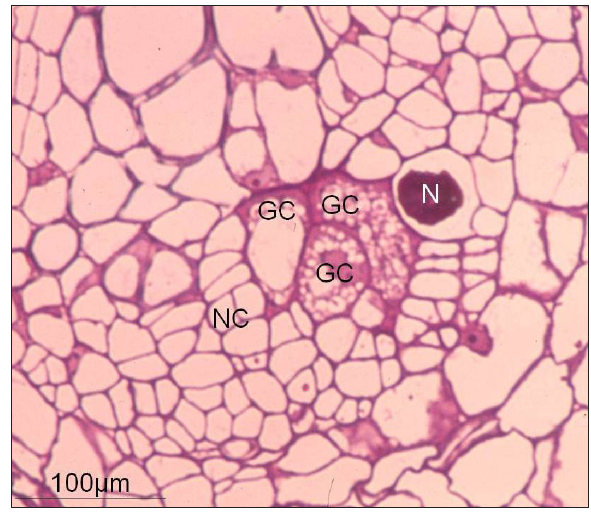
A transmission electron micrograph of a transverse section through an undifferentiated provascular cylinder showing necrotic cell tissue visible in the root of a resistant cultivar, LS5995, near the head of a feeding Meloidoyne incognita second-stage juvenile (J2) 2 days after